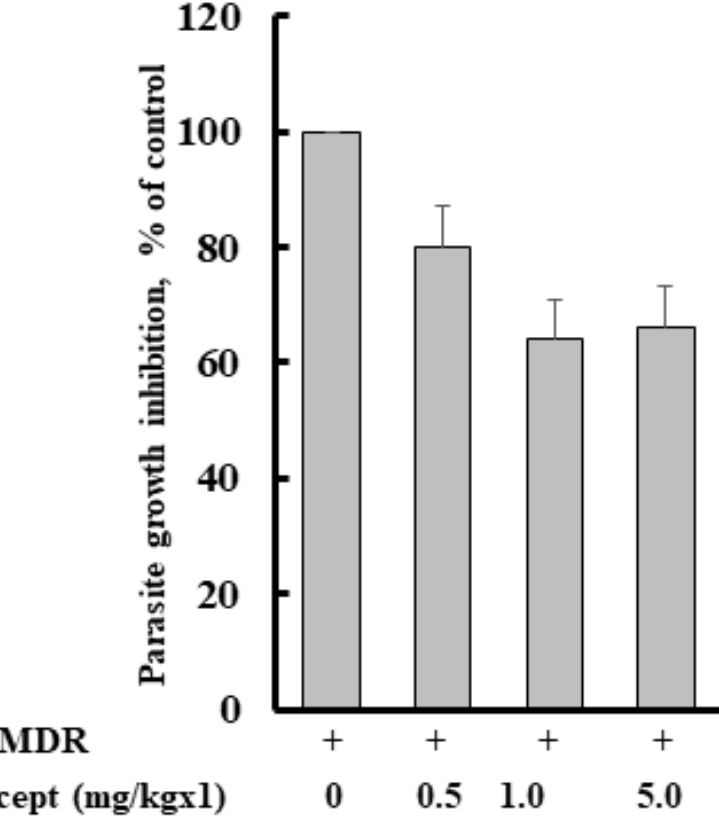
Figure 1. Effect of Etanercept treatment on Py MDR infection in Swiss mice. Etanercept was pre- pared in PBS and given subcutaneously just after intraperitoneal inoculation of 1 × 10 5 Py MDR infected RBCs/mouse ( n = 6). Parasitaemia was monitored on day four post infection and deter- mined by counting at least 1000 erythrocytes from thin blood smears stained with Giemsa under a 100× microscope.